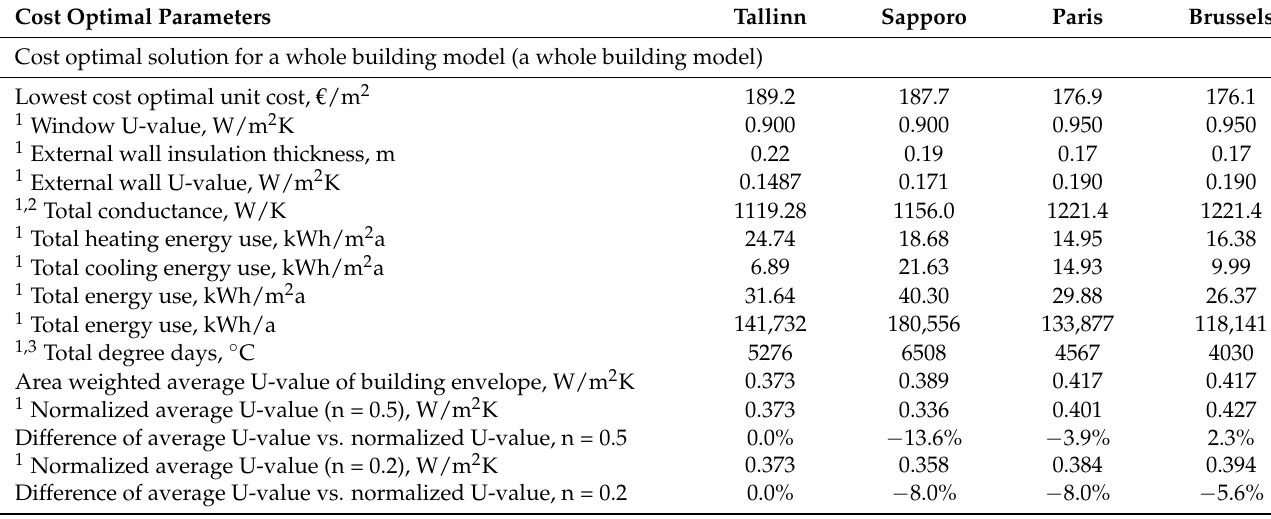
Table 5. Wall and window ‘U-value’ corresponding to the cost-optimal solution (based on investment and operational heating and cooling cost) for different climates.